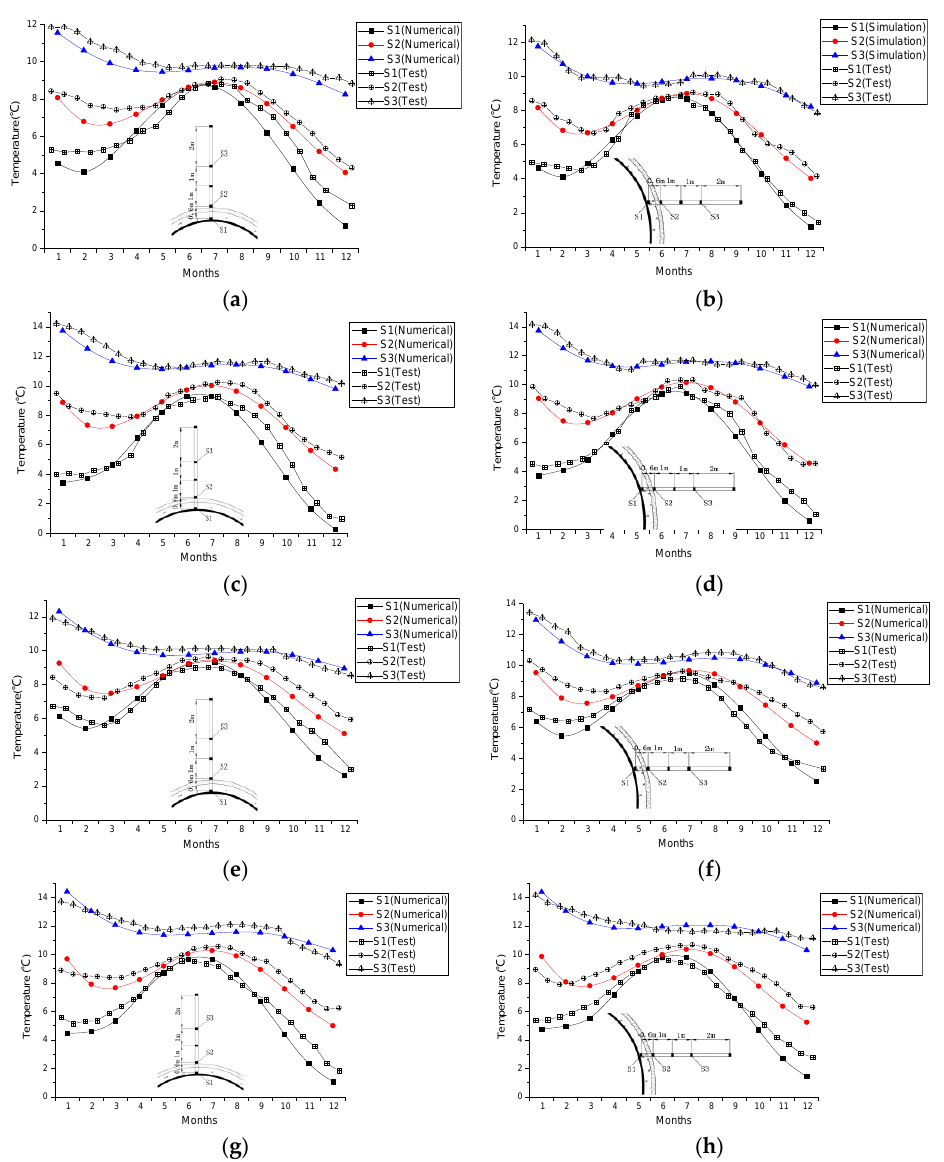
Figure 8. Test-numerical comparisons for: ( a ) tunnel vault at section C1, ( b ) spandrel of tunnel at section C1, ( c ) vault of tunnel at section C2, ( d ) spandrel of tunnel at section C2, ( e ) vault of tunnel at section C3, ( f ) spandrel of tunnel at section C3, ( g ) vault of tunnel at section C4 and ( h ) spandrel of tunnel at section C4.